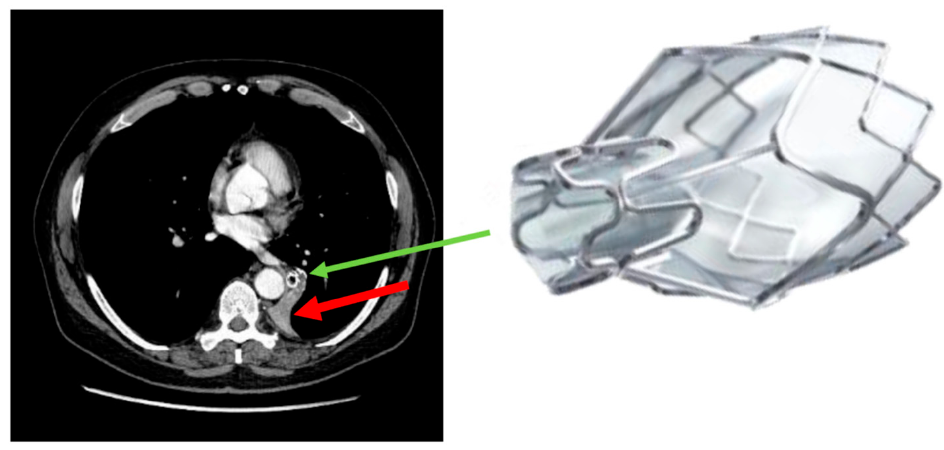
Figure 1. Atelectasis of the left lower lobe after endobronchial valve (EBV) implantation. The red arrow points at the atelectasis, the green arrow at the EBV.